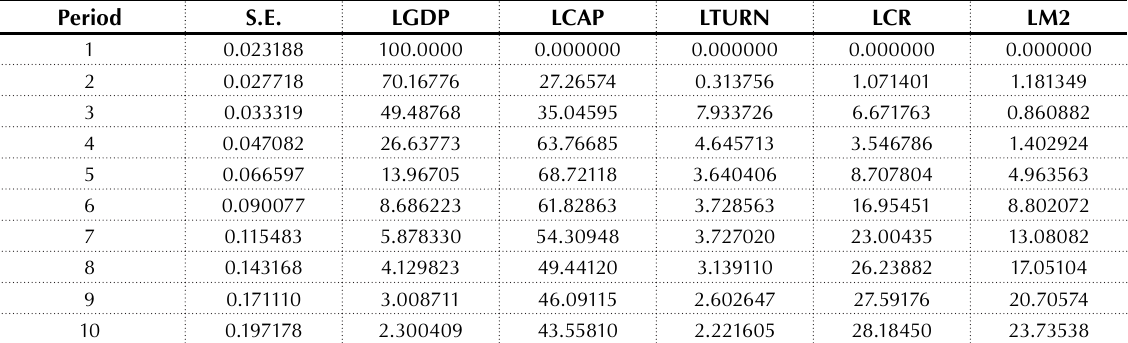
Table 7. VD of LGDP